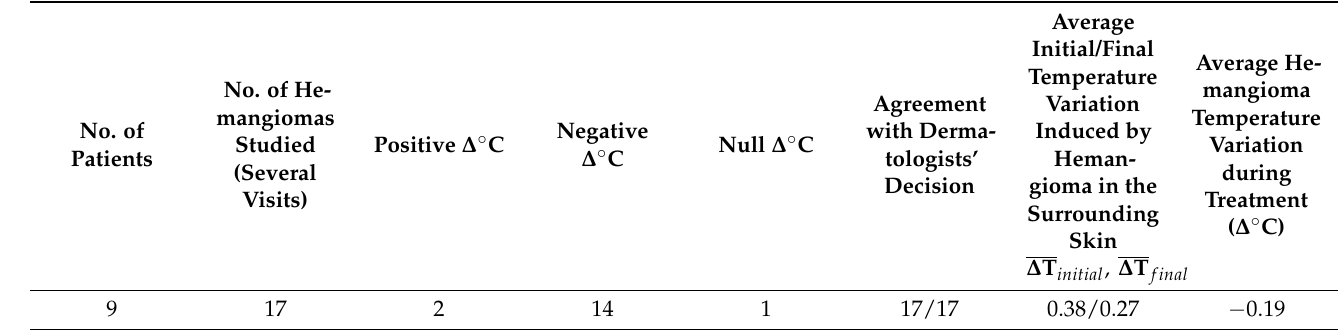
Table 2. Summary of the clinical experience analyzing infantile hemangiomas with a thermal camera (second phase of the study). Results obtained after examining nine patients in three sessions during their nine months of treatment.